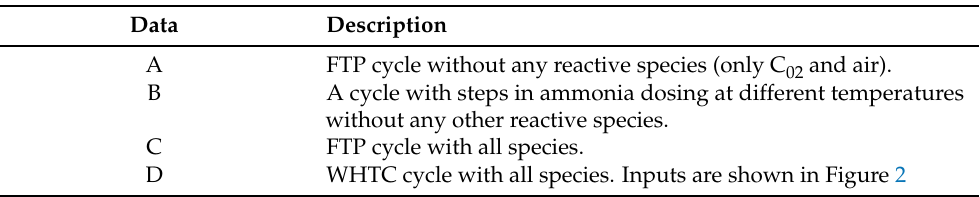
Table 2. Data used for parameterization and validation.